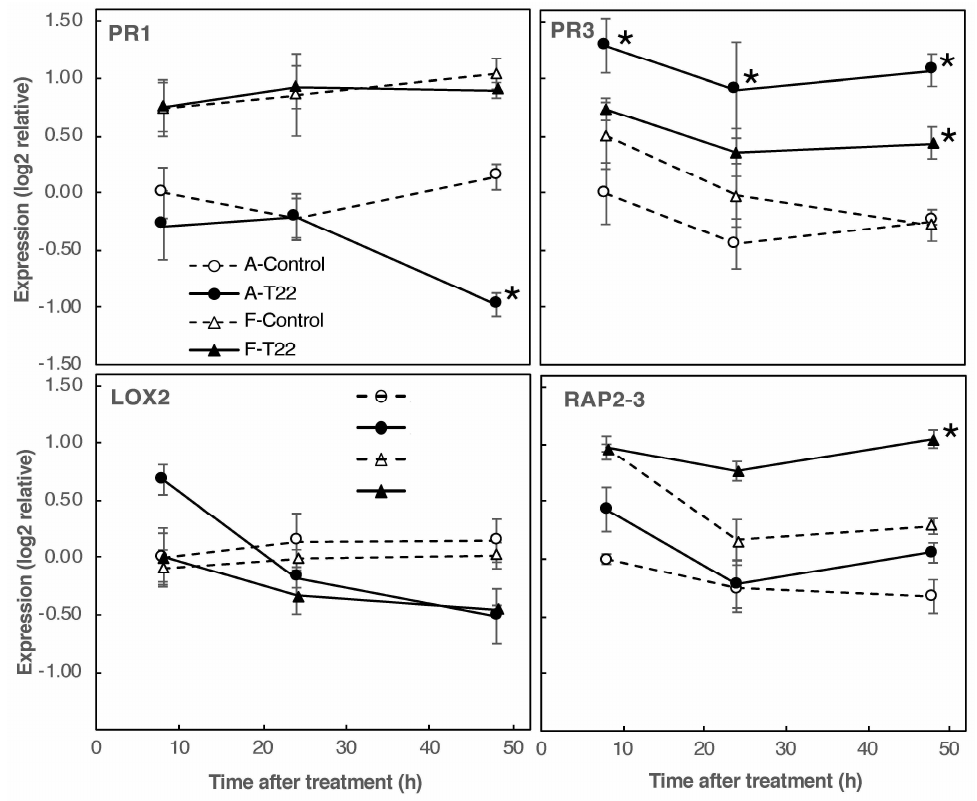
Figure 5. Gene responses to T22 treatment in sterile culture. Transcript levels for control and T22-treated sterile-grown roots of genotypes A and F are shown. Data are presented as average expression ± SE for 3–4 biological replicates. Values are standardized to line A controls 8 h, which were given the value zero. Significant differences between T22 treatment and control are denoted with asterisks.